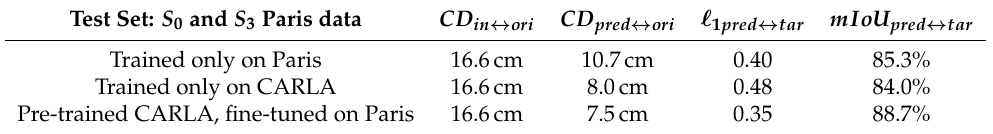
Table 7. Results of transfer learning for the scene completion task. CD is the mean Chamfer Distance between point clouds. (cid:96) 1 is the mean (cid:96) 1 distance between predicted and target TSDF measured in voxel units for 5cm voxels and mIoU is the mean Intersection over Union of TSDF occupancy. The mean is over 2000 chunks for Paris data. ori means original point cloud, in is input point cloud (10% of the original), pred for CD is the predicted point cloud (computed from predicted TSDF), pred for IoU, (cid:96) 1 is the predicted TSDF, and tar is the target TSDF. Test Set: S 0 and S 3 Paris data CD in ↔ ori CD pred ↔ ori (cid:96) 1 pred ↔ tar mIoU pred ↔ tar Trained only on Paris 16.6cm 10.7cm 0.40 85.3% Trained only on CARLA 16.6cm 8.0cm 0.48 84.0% 16.6cm 7.5cm 0.35